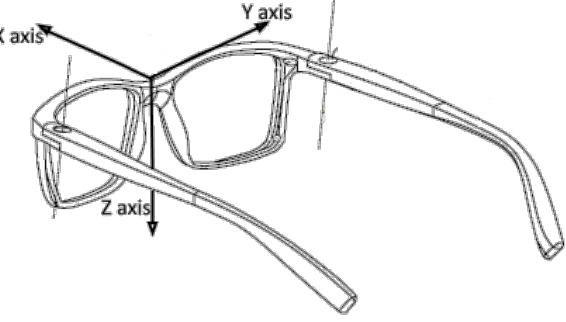
Figure 2. Accelerometer axes on Ellcie Healthy Smart